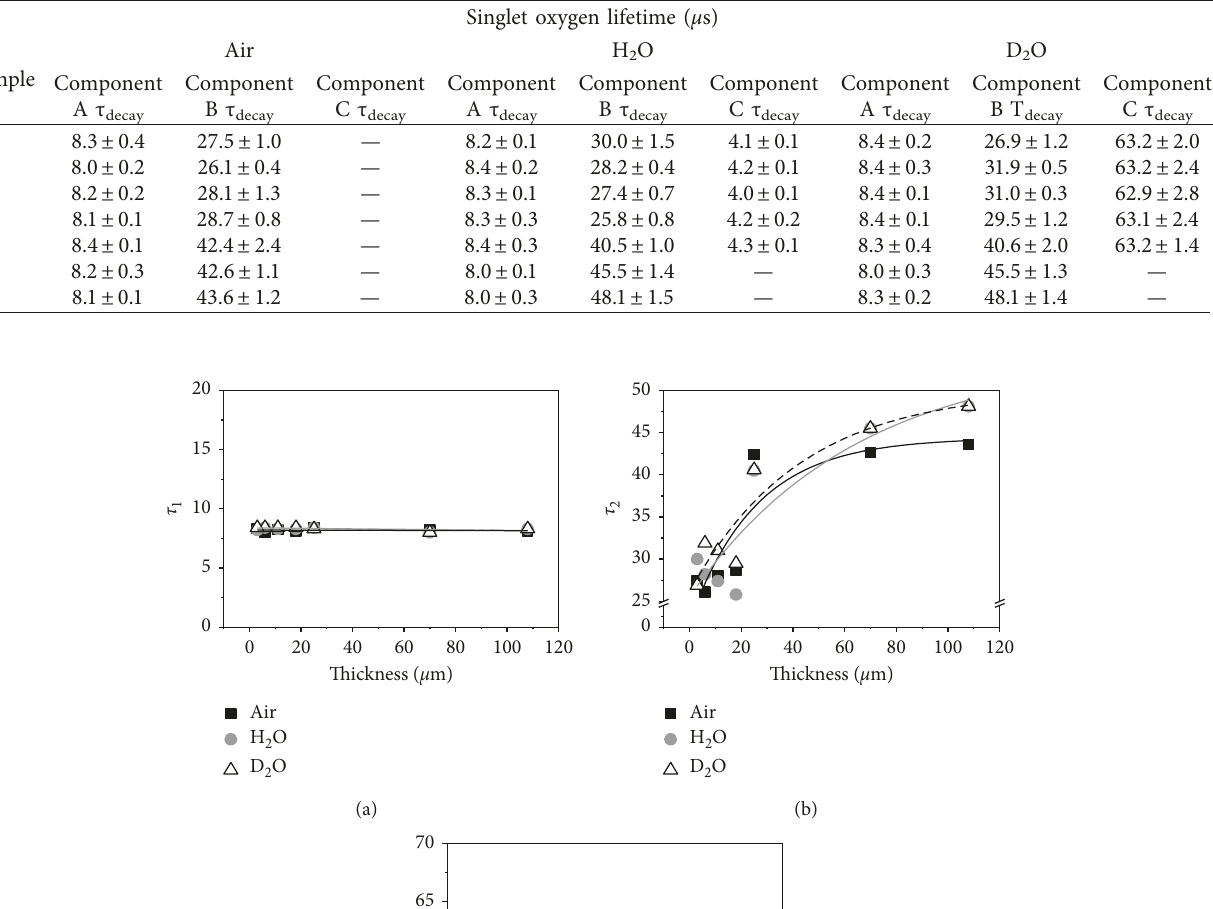
Table 2: Singlet oxygen lifetimes of PFPFs in the various environmental conditions ( χ 2 � 1.02 ±